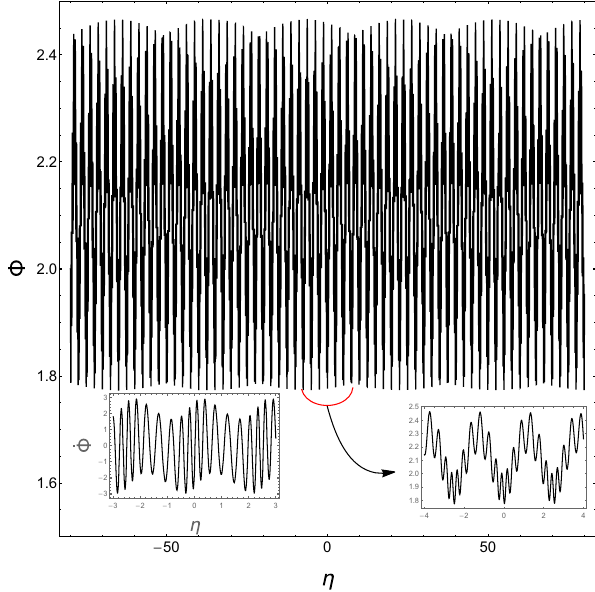
Z 0 = 2 . 116 and Q 0 = − 0 . 66. The right insets show the behavior of a and (cid:3) within a shorter time interval and the left ones are plotted for time derivatives of these